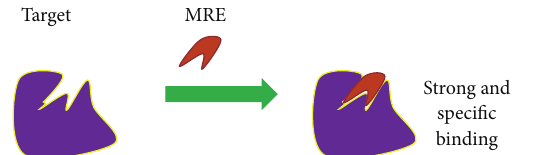
Figure 1: Cartoon explanation of molecular recognition element (MRE) binding. A MRE is any molecule with strong and specific binding to a target of